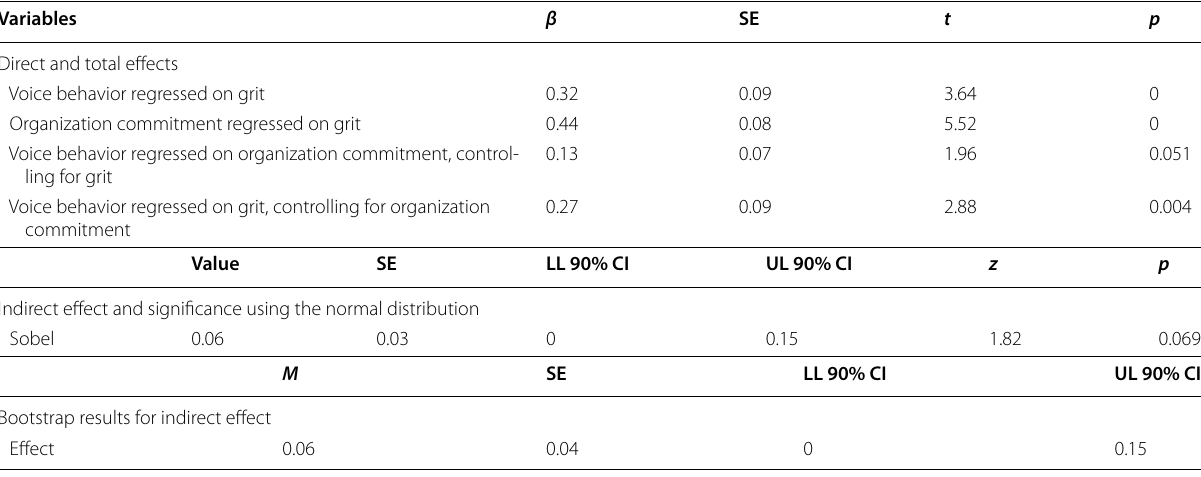
Table 3 Results of mediation